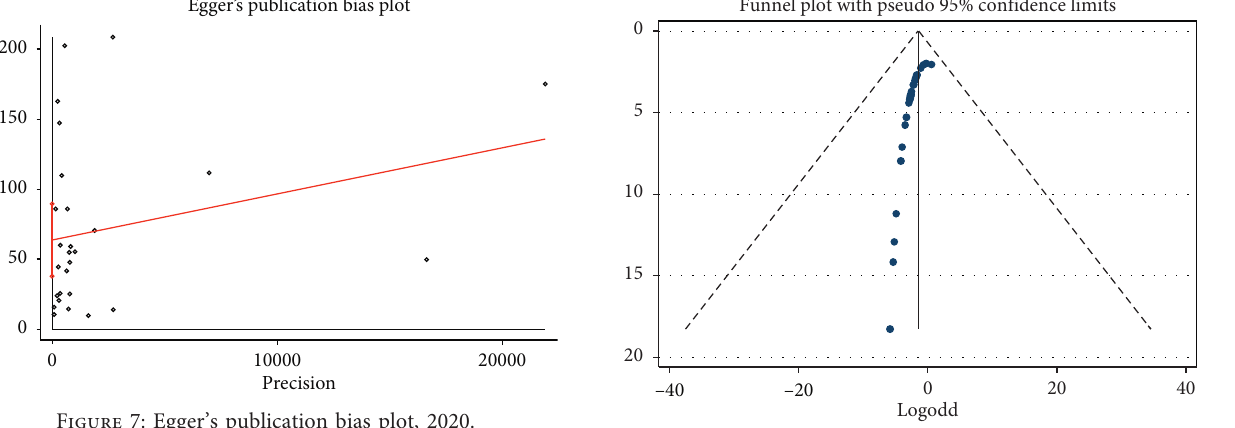
Figure 8: Funnel plot showing the results of the publication bias among studies,